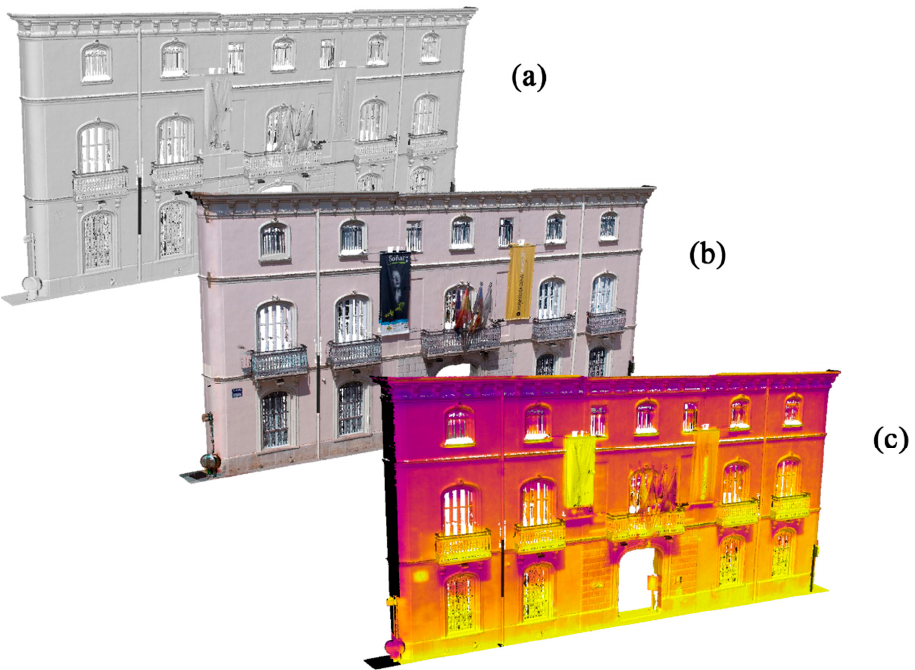
Figure 10. ( a ) LiDAR point cloud; ( b ) LiDAR point cloud (photogrammetric integration with colour images); ( c ) LiDAR point cloud (photogrammetric integration with TIR images).